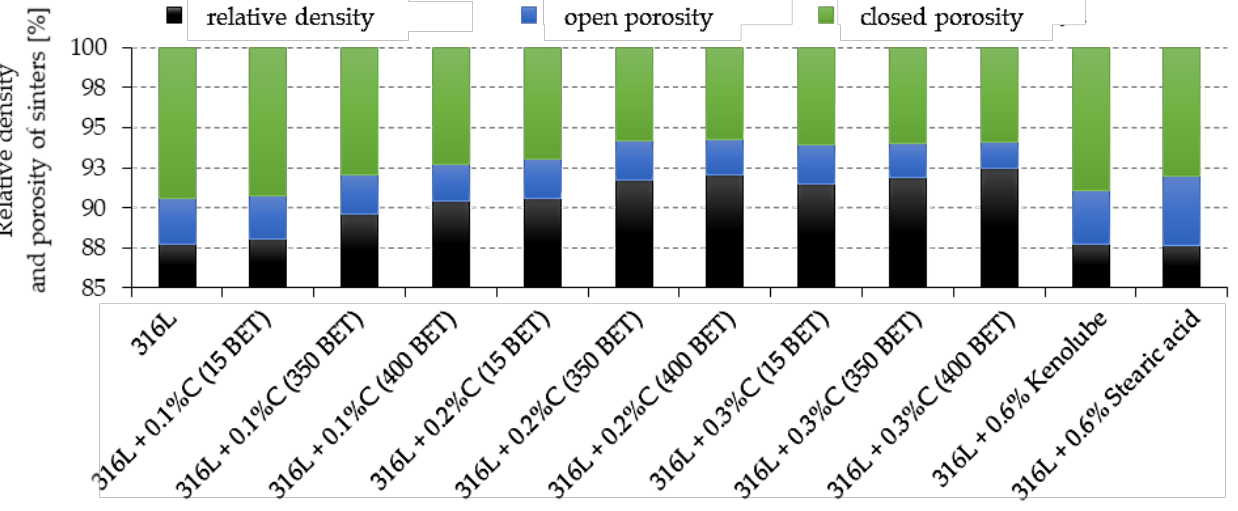
Figure 5. The relative densities and porosity of the sinters depend on the percentage composition of mixtures.